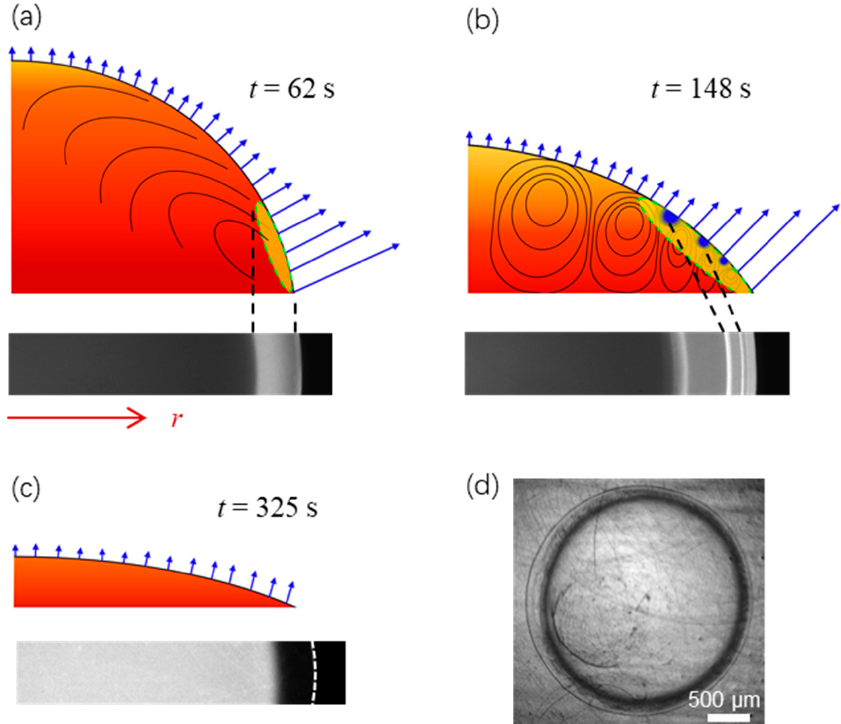
Figure 6. Schematic of the evaporation dynamics and the formation of cooling region in ( a ) (yellow within the dashed circle, type I fringe), cooling spots in ( b ) (blue, type II fringes), and the dark ring in ( c , d ) (due to the “coffee-ring” effect). The contact angle of the surface is of θ 0 = 87.3 ± 0.2 ◦